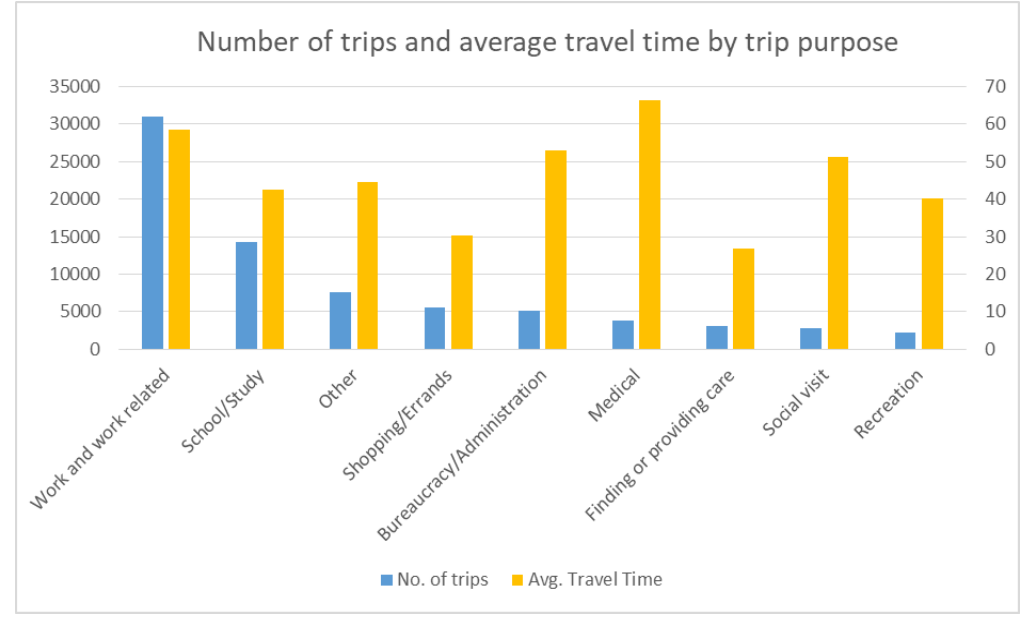
Figure 6. The number of trips and average travel time by trip purpose for all home-based trips.